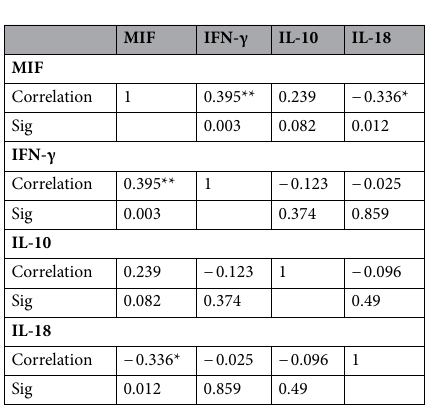
Figure 5. Comparison and correlation of MIF and IL-18 levels in serum and BAL of sarcoidosis patients. Boxplot depicts the differences of median and interquartile range of MIF. BAL samples displayed significant higher levels of MIF as compared to serum values using paired t-test ( p = 2.8e−4) ( A ). Boxplot depicts the differences of median and interquartile range of IL-18 in serum and BAL samples. IL-18 level was significantly higher ( p = 1.6e−15) in serum as compared to BAL ( B ). A correlation scatterplot of BAL IL-18 and BAL MIF values. There was a significant negative correlation between the levels of BAL IL-18 and BAL MIF (r = − 0.35, p = 0.02) ( C ). Correlation scatter plot displayed significant positive correlation between BAL MIF and BAL IFN-γ (r = − 0.395, p = 0.003) ( D ). p value < 0.05 was considered to be significant.